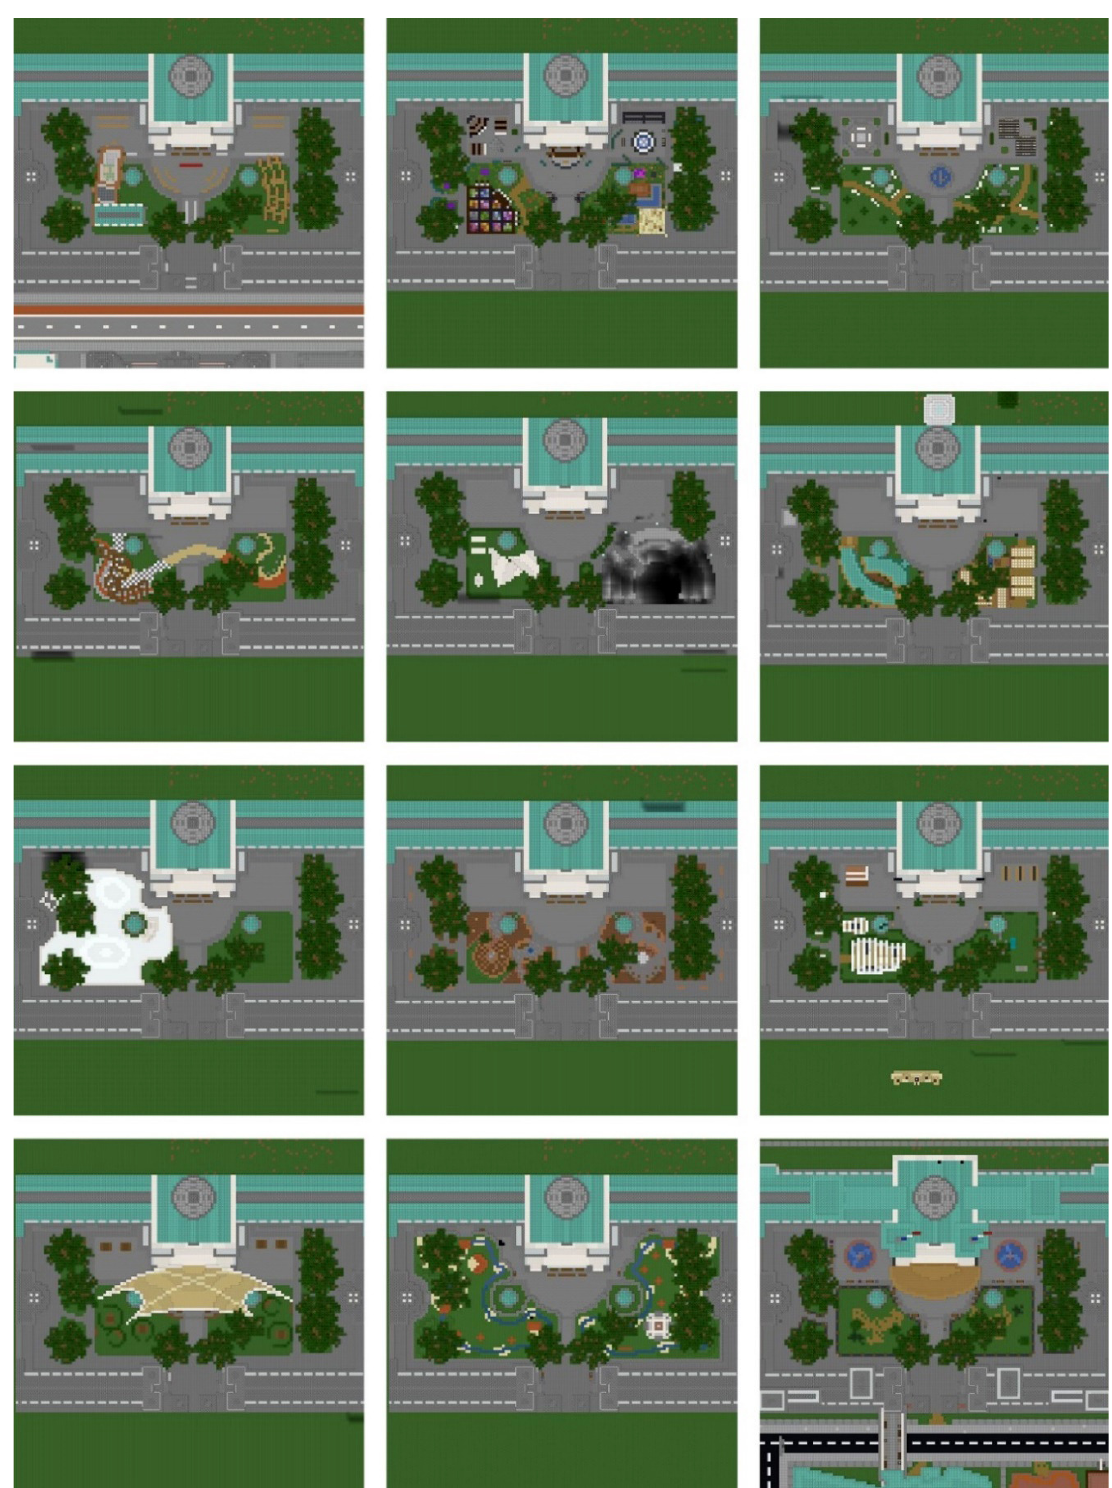
Figure 5. Sample of Minecraft plots: Plan view. an accessible, fun, and effective visualisation and design tool. The background of participants must be taken into account, however, with the vast majority having had pre‐ vious experience using